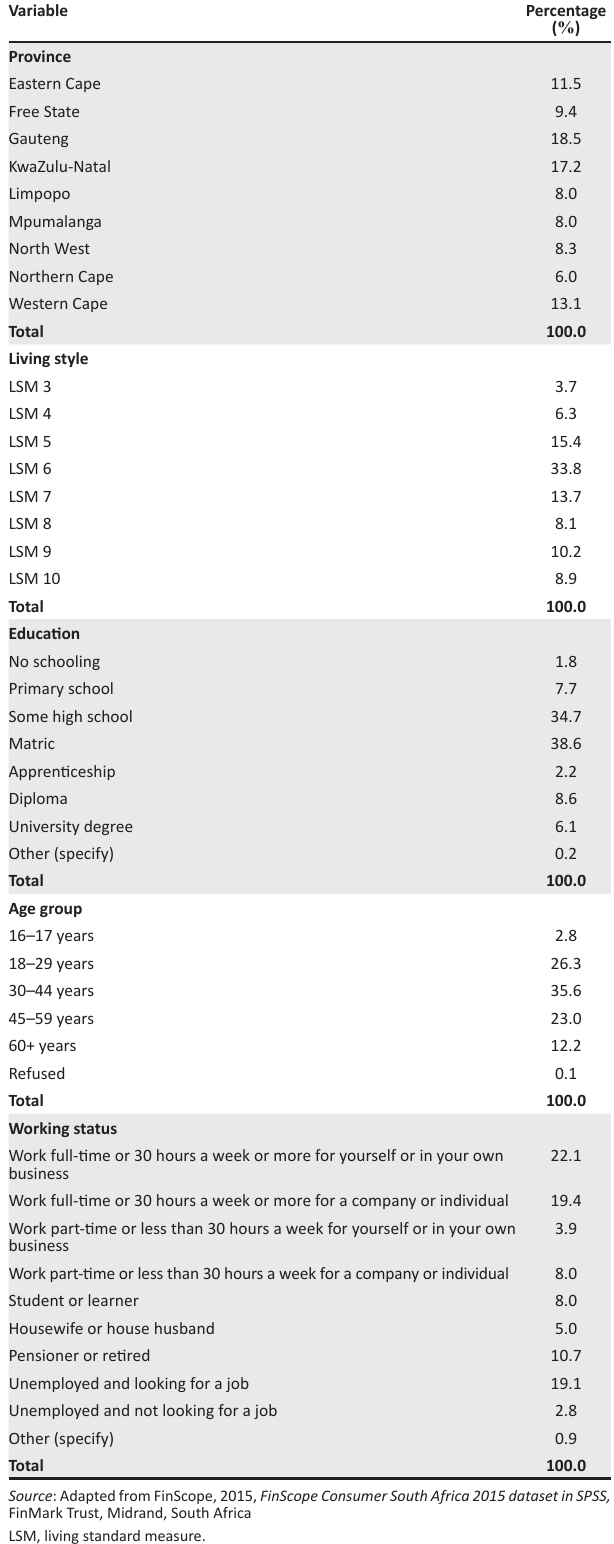
TABLE 1: Characteristics of survey respondents ( n = 5000,